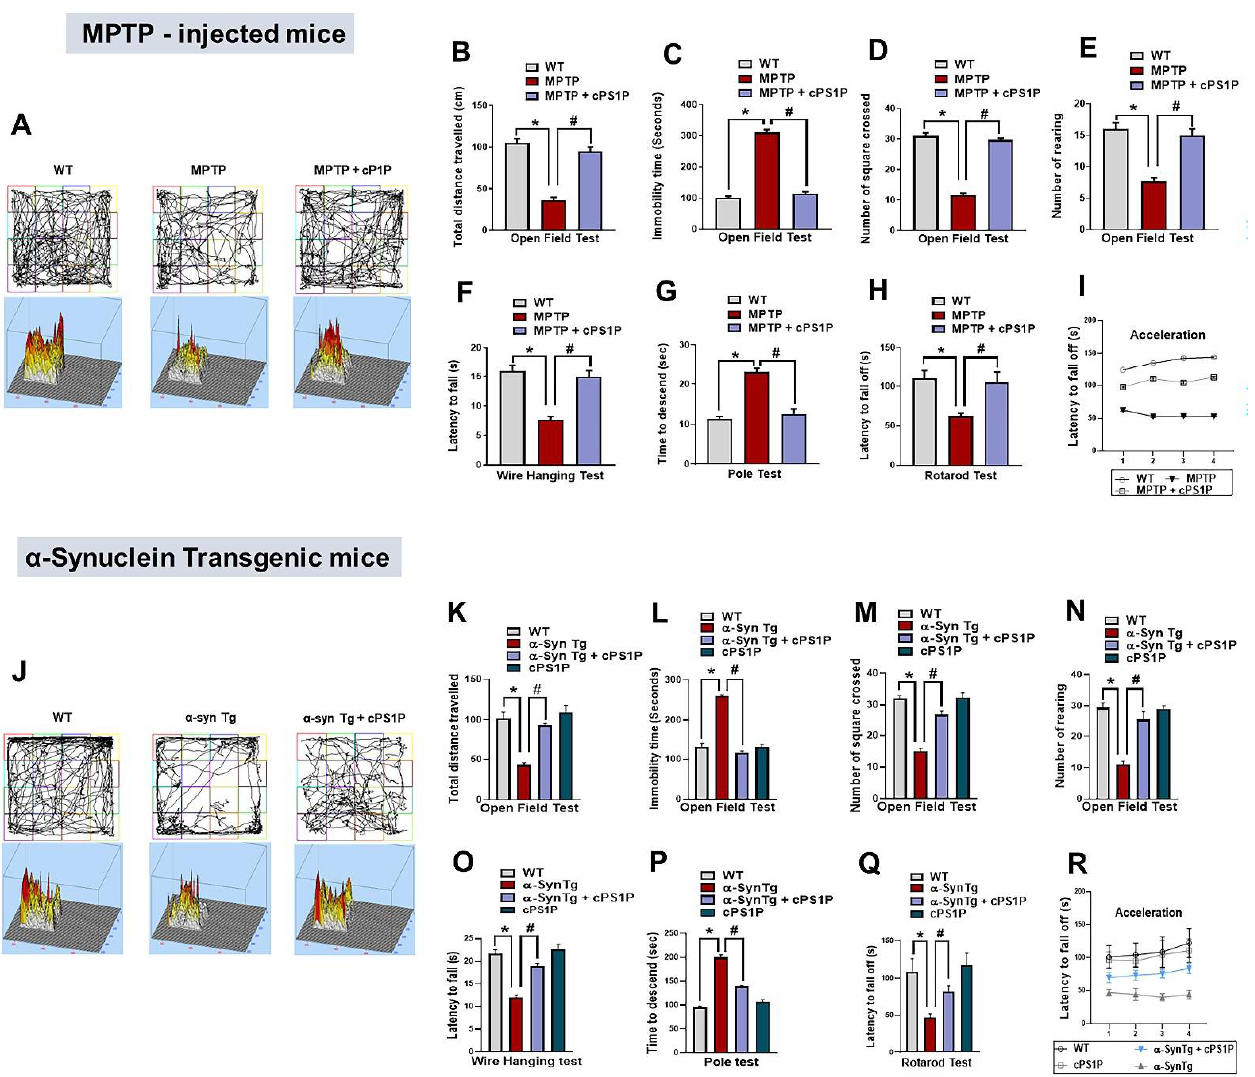
Figure 2. Effects of cPS1P against motor dysfunctions in the MPTP and NSE-h α Syn PD mouse models. ( A , B , J , K ) Graphical representation showing the total distance traveled by the mouse in the open field box of MPTP and NSE-h α Syn PD mouse models (n = 8 mice/group/model). ( C , L ) Graphical representation showing the immobility time of the mouse in the open filed box of MPTP and NSE-h α Syn PD mouse models (n = 8 mouse/group/model). ( D , M ) Graphical representation showing the number of squares crossed by the mouse in the open filed box of MPTP and NSE-h α Syn PD mouse models (n = 8 mice/group/model). ( E , N ) Graphical representation showing the mouse’s rearings in the open filed box of MPTP and NSE-h α Syn PD mouse models (n = 8 mice/group/model). ( F , O ) Graphical representation showing the latency to fall in the wire hanging test of MPTP and NSE-h α Syn PD mouse models (n = 8 mice/group/model). ( G , P ) Graphical representation showing the time to descend to the ground in the pole test of MPTP and NSE-h α Syn PD mouse models (n = 8 mice/group/model). ( H , I , Q , R ) Graphical representation showing the latency to fall off from the rotarod test of MPTP and NSE-h α Syn PD mouse models (n = 8 mice/group/model). The values indicate the mean ± SEM. The significant differences have been given in the graphs. * Significant difference between the control and model group; # Significant difference between the model and cPS1P co-treated mouse. p < 0.05 was considered significant difference between the groups, as measured with one-way ANOVA followed by Tukey’s multiple comparison